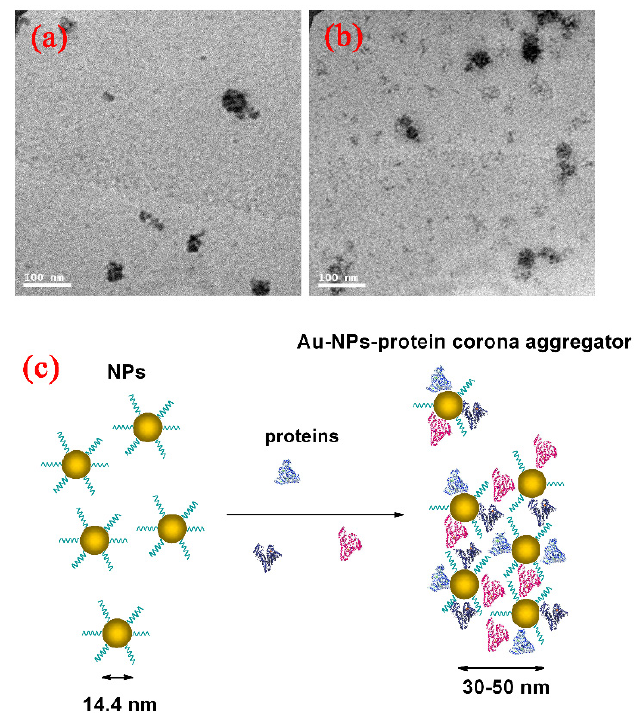
Figure 6. Direct observation of Au-protein corona aggregator by TEM imaging in H22 ( a ); HepG2 cells ( b ); and blood dynamic ( c ) of GNPs in physiological environment.